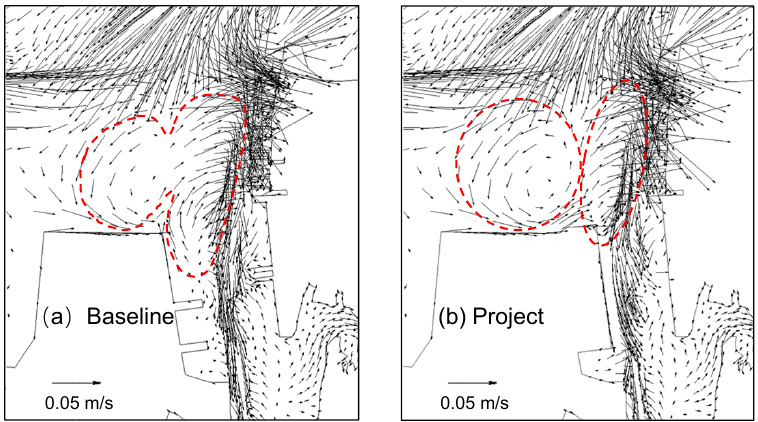
Figure 15. Bottom residual current near the Elizabeth River mouth: ( a ) baseline condition; ( b ) project scenario. The “double-gyre” pattern is highlighted by